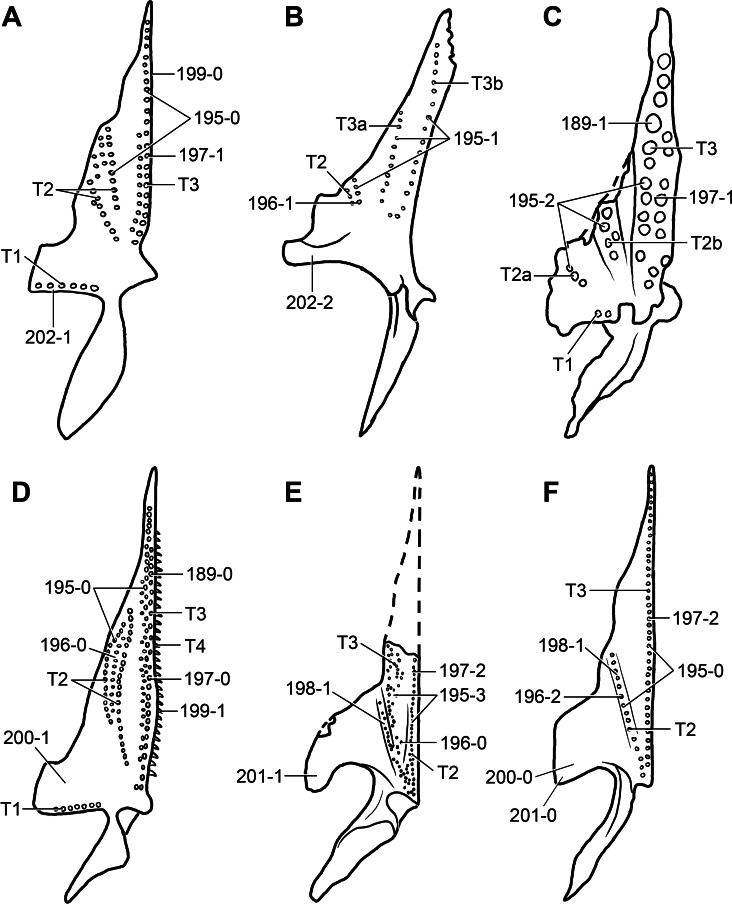
Reconstructed pterygoids of non-archosaurian neodiapsids.(A) Youngina capensis (modified from Gow, 1975; BP/1/3859; GHG K 106); (B) Gephyrosaurus bridensis (redrawn from Evans, 1980); (C) Azendohsaurus madagaskarensis (redrawn from Flynn et al., 2000); (D) Prolacerta broomi (modified from Gow, 1975); (E) Doswellia kaltenbachi (modified from Dilkes & Sues, 2009; USNM 214823); and (F) Chanaresuchus bonapartei (modified from Romer, 1971a; PULR 07; PVL 4575, 4586). Numbers indicate character-states scored in the data matrix and anterior direction is towards the top of the figure. Abbreviations: T1–4, tooth fields T1–T4. Not to scale.